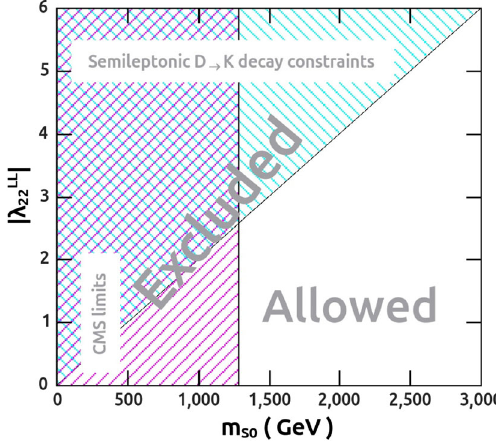
Fig. 7 Combined limits on second-generation leptoquark S L